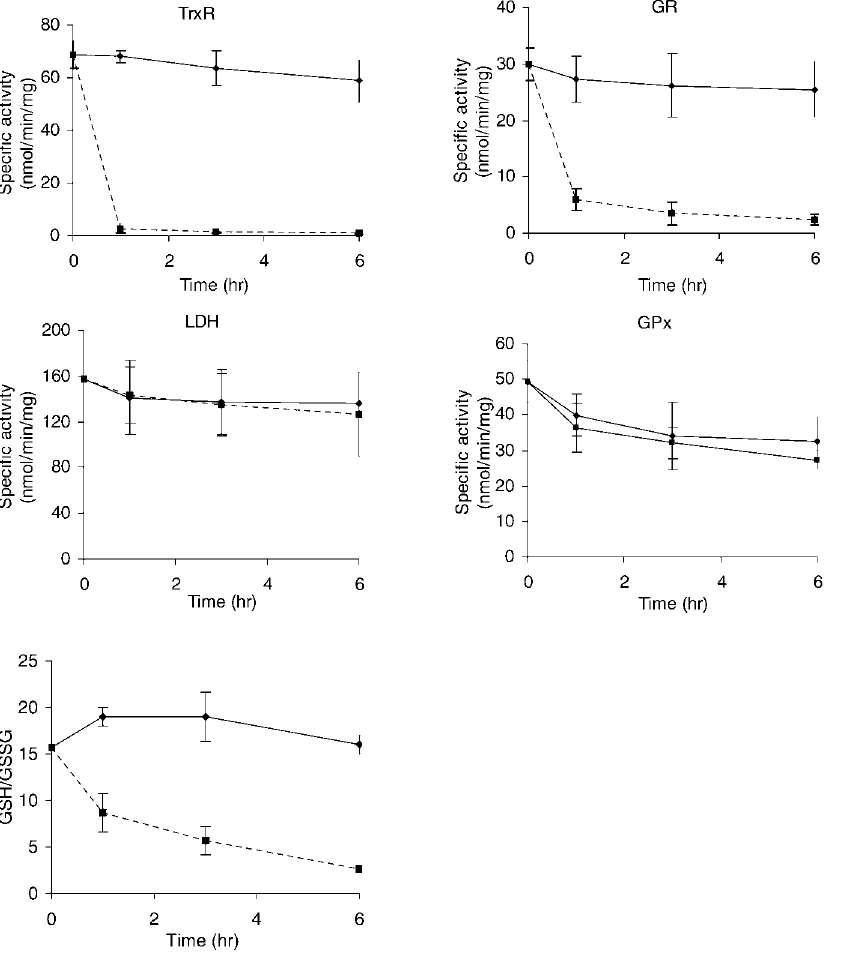
Figure 5. The Activity of Auranofin against Cultured Schistosoma mansoni Each point is the average of three independent experiments 6 the standard deviation. (A) Specific enzyme activities of TrxR, GR, LDH, and GPx in worm homogenates from control worms (solid lines) and worms treated with 10 l M AF (dashed lines). (B) Ratio of GSH:GSSG in worm homogenate from control worms (solid line) and worms treated with 10 l M AF (dashed line). Each assay was done in triplicate and each experiment was done three times. The error bars show the standard deviation of the three replicate